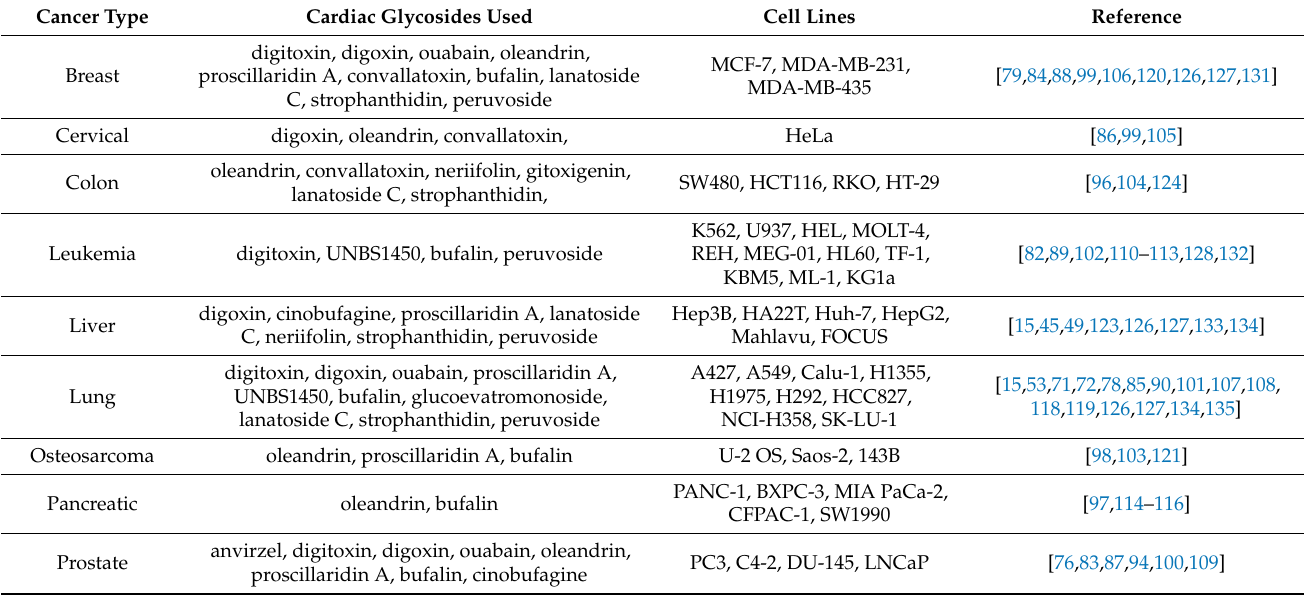
Table 2. Anticancer effect of cardiac glycosides against different cancer cell